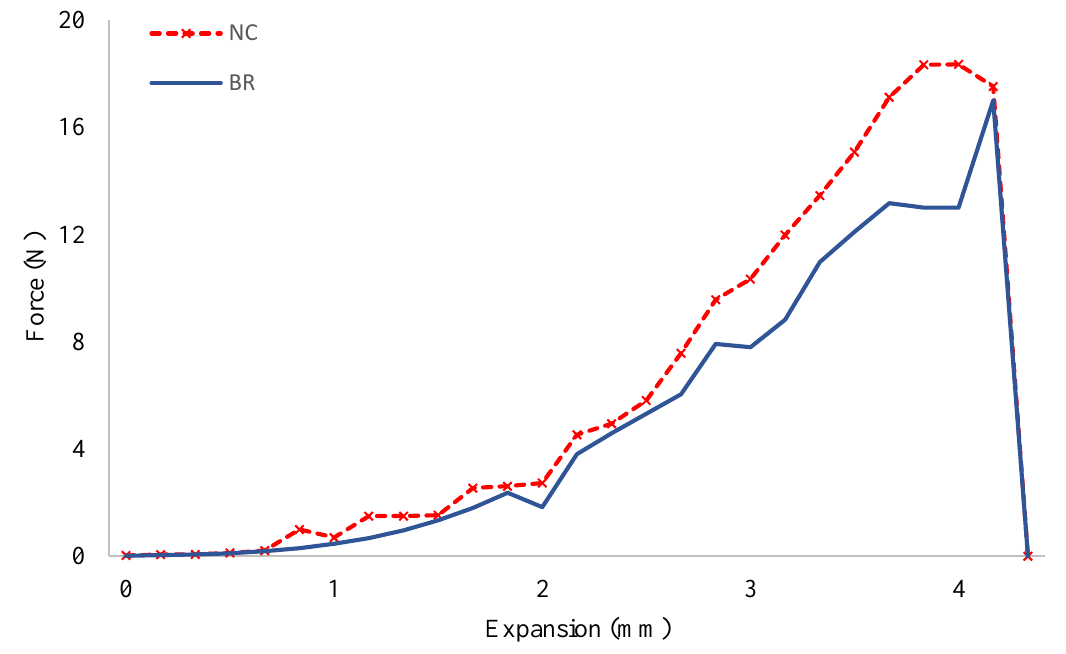
Figure 6. The mechanical properties of the cell-seeded scaffolds cultured for two weeks in the absence of a bioreactor as the negative control (NC) and in the bioreactor (BR) were tested by a tensile test. The breaking point was comparable for both constructs given a force of around 18 N.